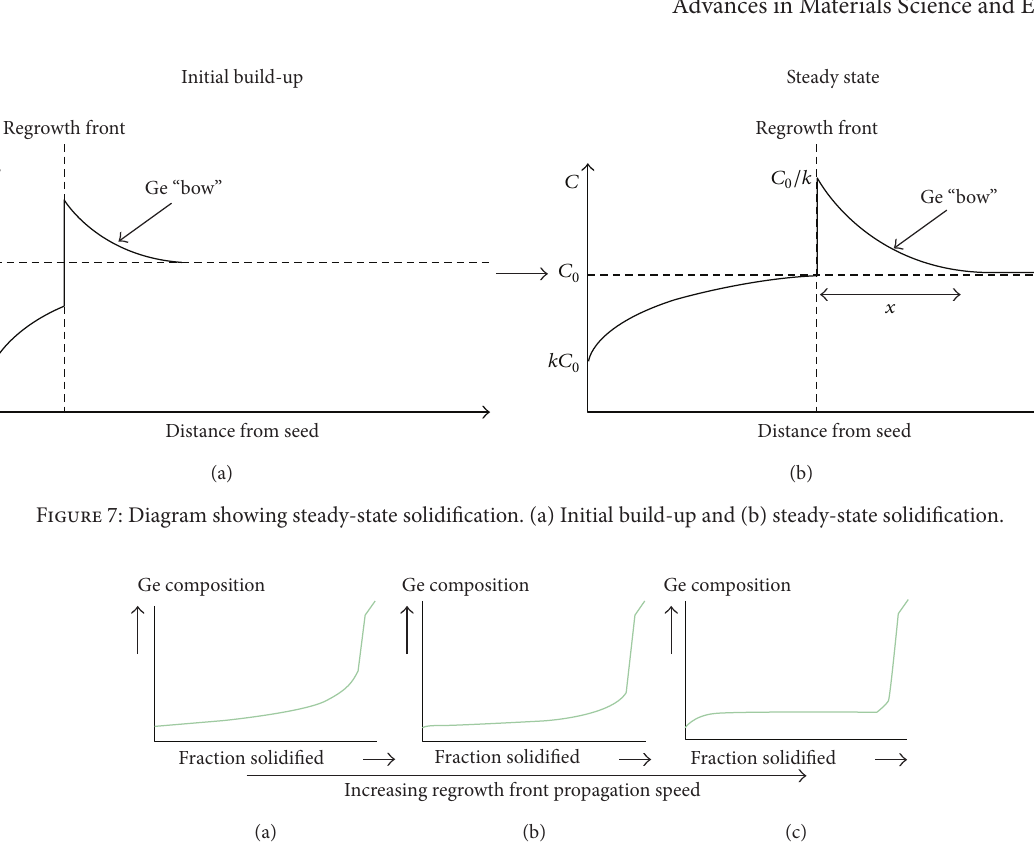
Figure 8: Simulations of Ge composition profiles formed by steady-state solidification using the University of Cambridge software [44] showing increasing regrowth front propagation speed from (a) to